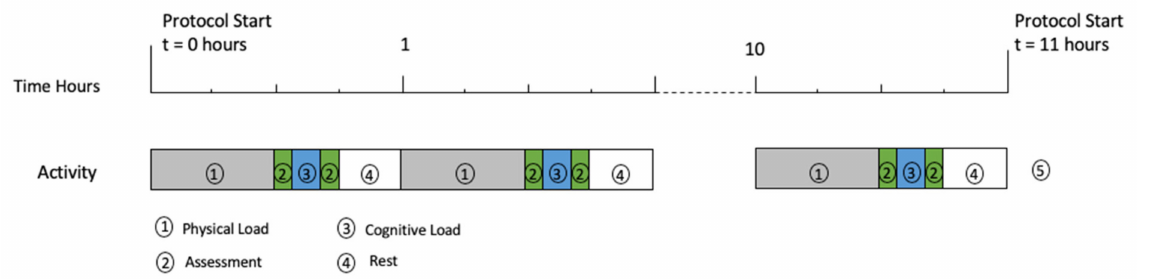
Figure 1. Fatigue